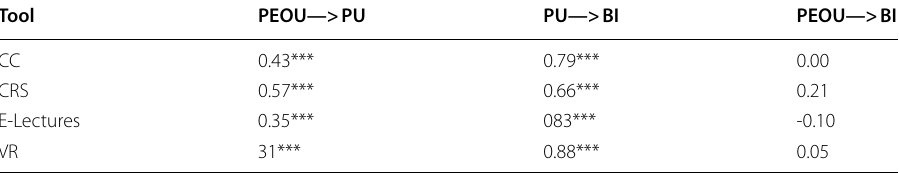
Table 4 Path loadings and significance testing for the PLS modelled TAM foe all tools